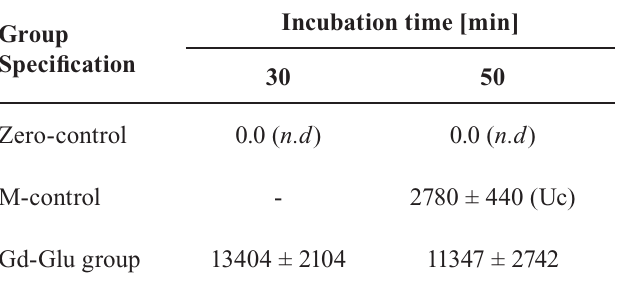
TABLE I - Metal mass concentrations, in mg.g -1 , of dried cell mass at the three groups: Zero-control, M-control, and Gd- Glu for incubation times of 30 and 50 min